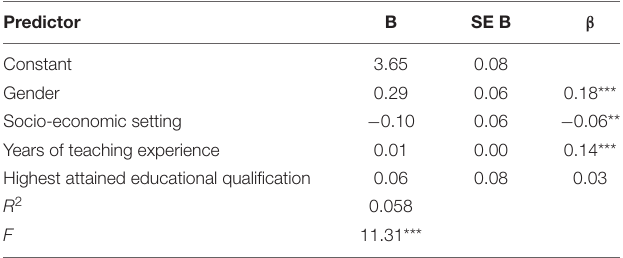
TABLE 3 | Multiple regression analysis predicting the Structure of Mathematical Knowledge belief from gender, socio-economic setting, years of teaching experience, and highest attained education qualification.